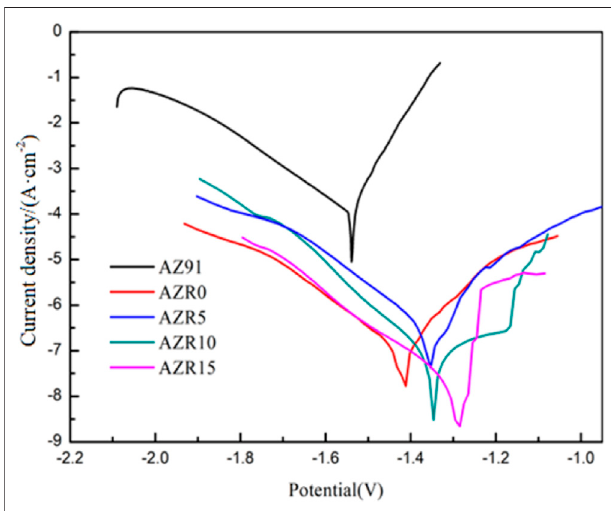
FIGURE 5 | Potentiometric polarization curves of the different samples.